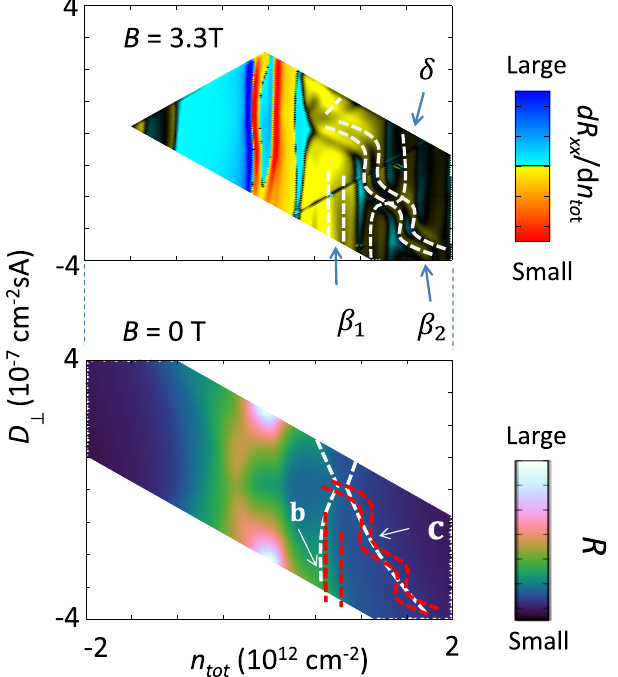
Figure 4. Top and bottom gate voltage dependences at B = 3.3 T and B = 0 T. (Top) A map of derivative of longitudinal resistivity R xx with respect to total carrier density δ as a function of n tot and D ⊥ B = 3.3 T and T = 4.2 K. Dashed lines show positions of center of some Landau levels. β 1 and β 2 denote zero-mode Landau levels of light-mass bilayer-like band. δ is a Landau level with a higher index. δ and β 2 cross at ≈ . × n 1 3 10 − cm 2 and = − × − D 2 10 7 − cm sA 2 . (Bottom) Similar plot of the resistivity at B = 0 T and T = 4.2 K (same as ⊥ Fig. 2c). Dashed red lines indicate position of zero-mode Landau levels β 1 and β 2